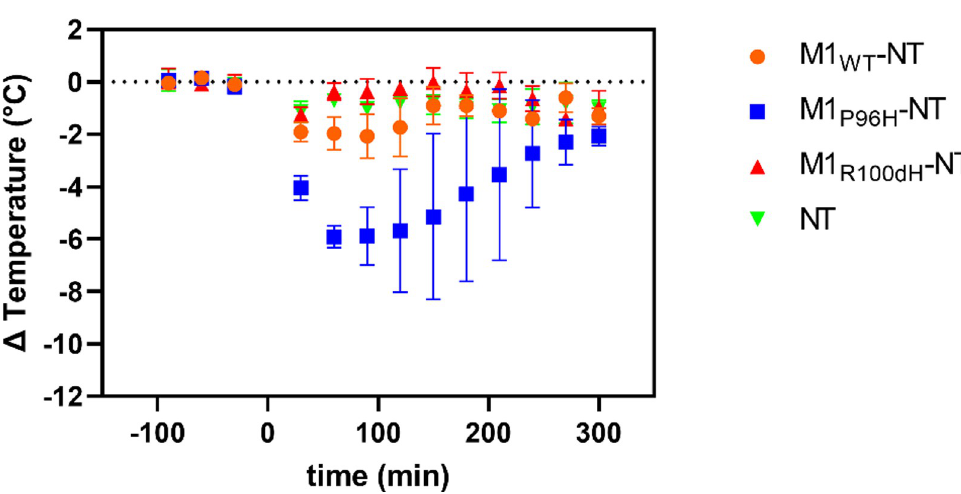
Fig 3. The use of NT fusion to VHHs for VHH screening via hypothermia as an indication of CNS target engagement. The M1 variants with different affinities to mTfR have different hypothermic effects. Among the three M1 variants injected to mice at the same dose 600nmol/kg body weight (n = 3 per group), M1 P96H -NT produced the most prominent hypothermia effect, with a maximum temperature drop of about 6C˚ and duration for about 4hrs.